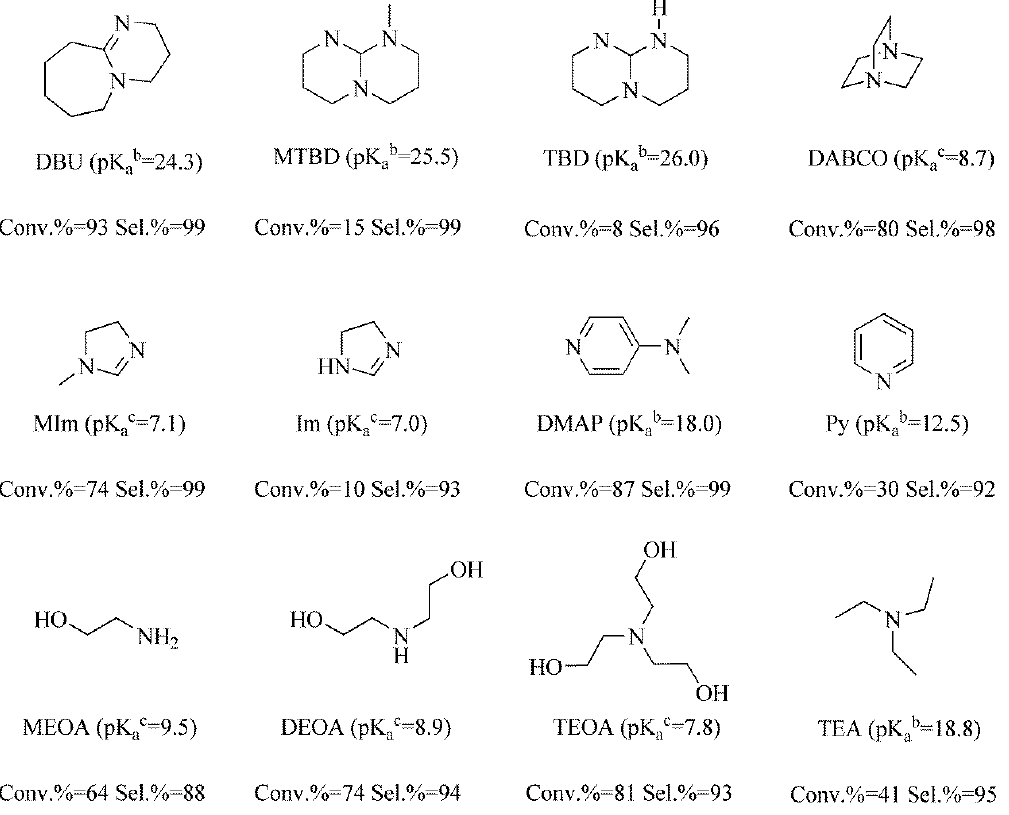
Scheme 4. Chemical structures of organic bases used in the CO 2 cycloaddition reaction and the effect of organic bases on the conversion of PO. a Reaction conditions: PO (1 mL), base (225 mg), cellulose (15 mg), 120 °C, 2.0 MPa, 2 h. Determined by GC/GC-MS, the main by-product is 1,2-propylene glycol.